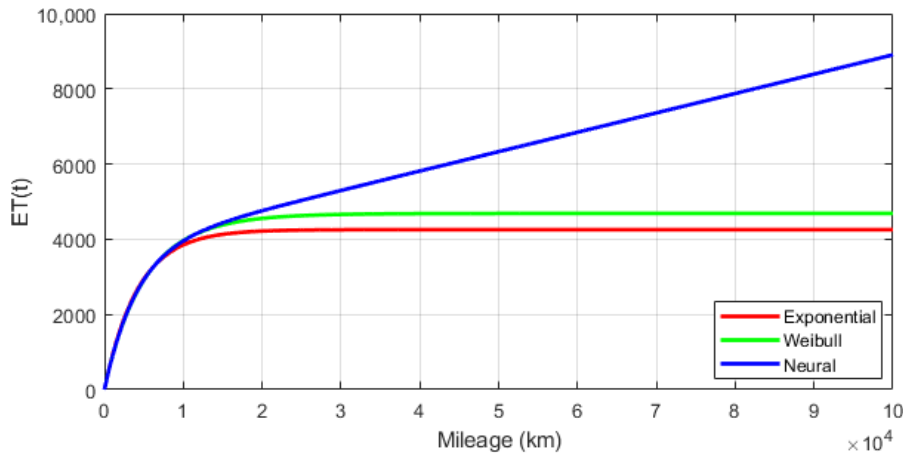
Figure 13. Definite integral graph of reliability function depending on integration interval. Table 8. Expected mileage between failures.